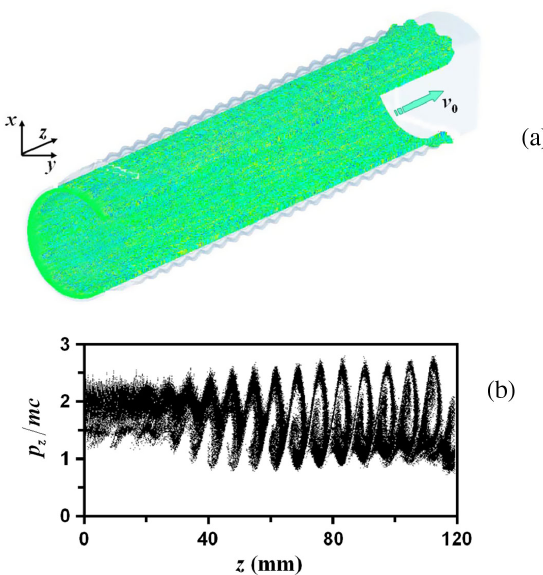
FIG. 14. Results of CST PIC simulations of the electron beam dynamics in the project of SWOs based on the SINUS-6 accelerator: (a) the electron trajectories and (b) dependence of =mc on the axial z — the particles normalized momentum p z coordinate in the stationary regime of